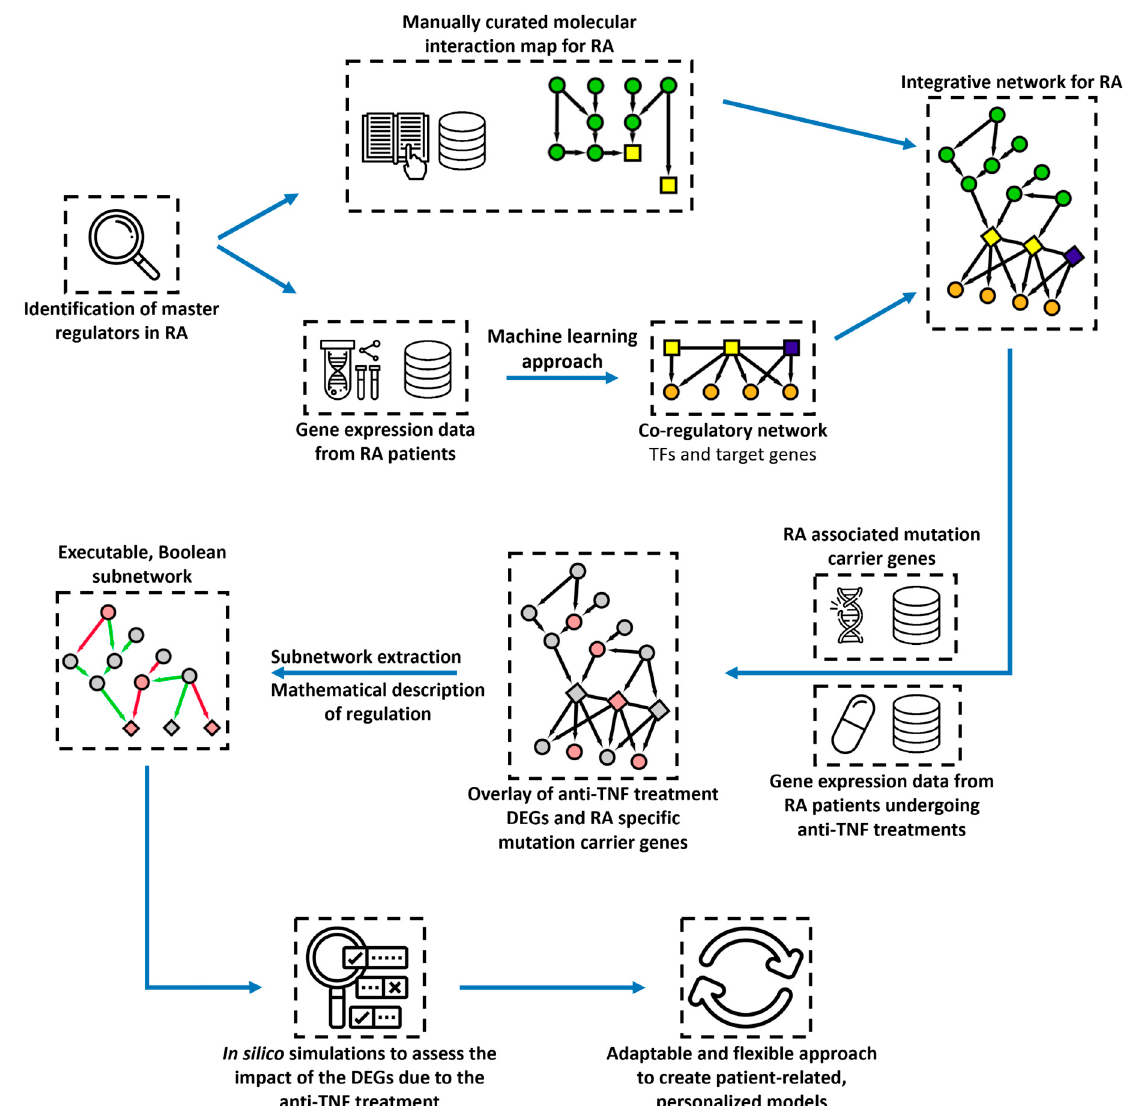
Figure 1. Workflow for creating an integrative and executable network for rheumatoid arthritis (RA). The steps include network inference and identification of master regulators, the combination of the co-regulatory network with curated signalling cascades, the analysis of omics data of anti-TNF treatment, and the addition of Boolean rules to create adaptable and flexible personalised models for in silico simulations.